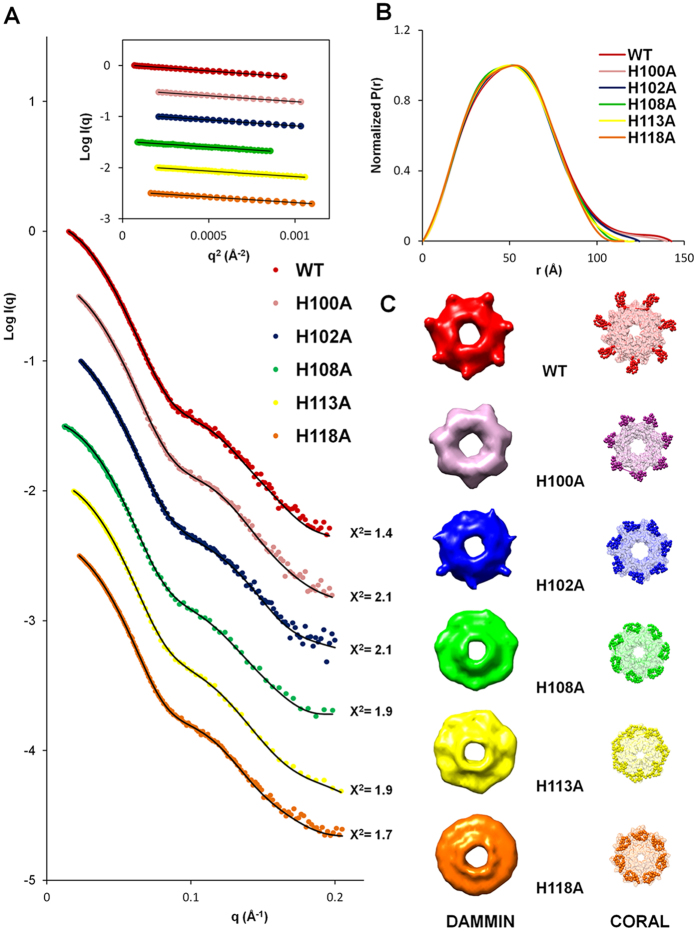
SAXS data analysis and ab initio models of WT and variant proteins.(A) SAXS intensity profiles showing the log of X-ray scattering intensity (logI) as a function of the scattering vector q for experimental scattering data. The Guinier curve-fitted lines for Rg values to the experimental data are superimposed (Inset). Both curve profiles were corrected and offset for clarity of presentation, and showed good quality of protein samples. (B) Overlay of normalized p(r) distribution plot calculated using Primus for WT and variants. (C) The ab initio models of averaged molecular envelopes from DAMMIN (left) and rigid body models from CORAL (right) are shown in the same colors as those in panel A. The models showed good fit with the experimental SAXS curve in (A) (χ2 = 1.4–2.1).